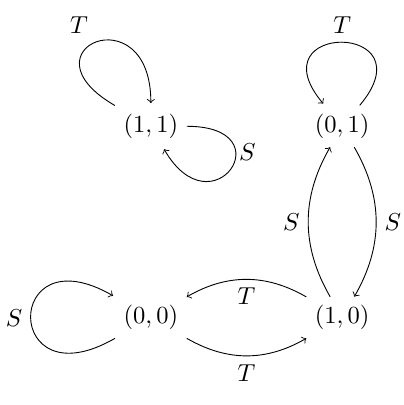
Figure 1 . Change of spin structures under the mapping class group transformations T, S .